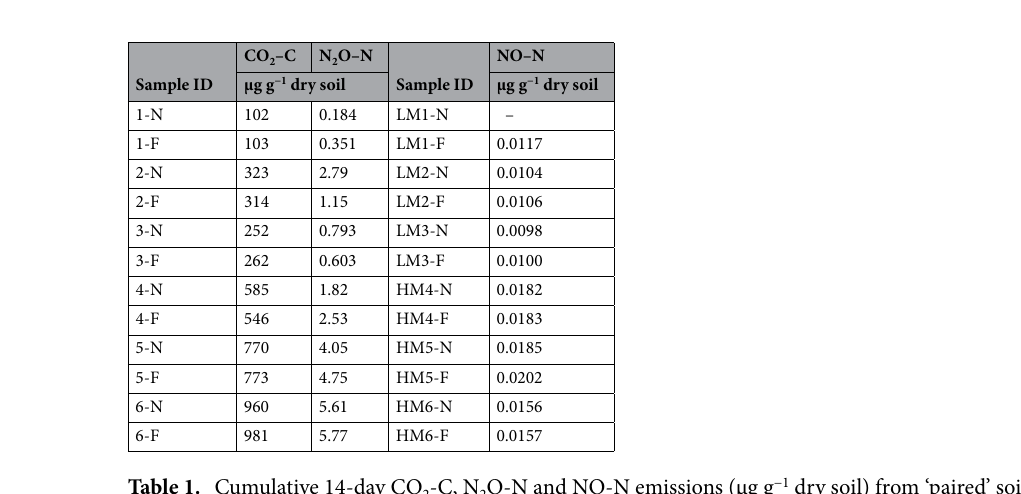
Table 1. Cumulative 14-day CO 2 -C, N 2 O-N and NO-N emissions (µg g −1 dry soil) from ‘paired’ soil units amended with non-freeze-dried (N) or freeze-dried (F) sheep urine. Urine samples are numbered and samples in FD-2 are identified by ‘LM’ for ‘low mixture’ or ‘HM’ for ‘high mixture’.